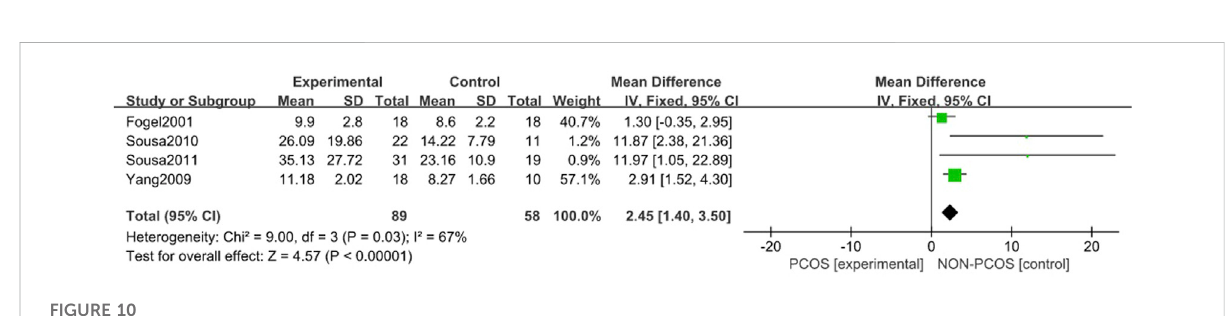
PCOS and sleep ef fi ciency, and further reduce the clinical heterogeneity of the study subjects, a subgroup analysis of the study population was performed (Figure 9) in which the